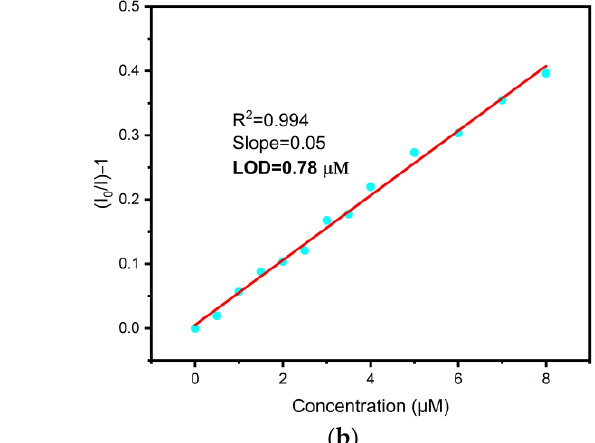
( b ) Figure 6. Fluorometric titration of gossypol: ( a ) emission spectra of MOF 1 ethanol suspension at 310 nm excitation and different amounts of gossypol added; ( b ) Linear approximation of lumines- cence quenching for LOD calculation. The relative luminescence quenching values were calculated from the integral intensities. In order to explore the possibility of using MOF 1 for gossypol detection in the cot- tonseed oil, the fluorometric titration was repeated as described above, only a fixed amount of refined cottonseed oil was added to the solution as the background. This ap- proach allows the estimation of the interference of multiple oil components, such as satu- rated and unsaturated triglycerides, tocopherols, tocotrienols, triterpene alcohols and